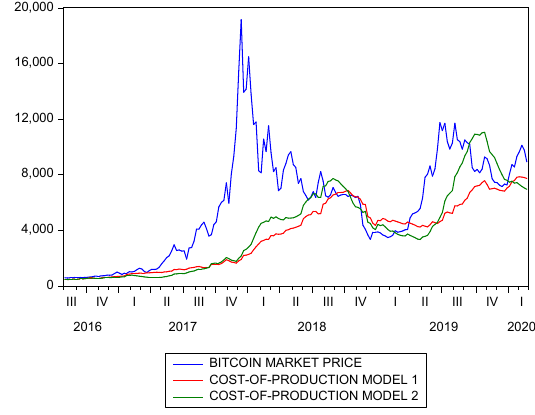
Figure 6. Cost-of-production model prices: Model 1 and Model 2 from Equation